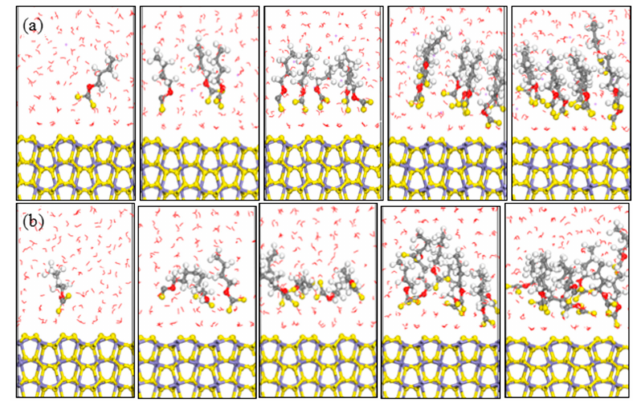
Figure 4. Equilibrium configurations of different butyl xanthate concentrations on pyrite surface in aqueous solution ( a ) NVT; ( b ) NPT; (Color codes: red = O, white = H, yellow = S, grey = C, iron grey = Fe, purple = Na; The above pictures is 1, 3, 5, 8, and 10 numbers of xanthate, respectively).